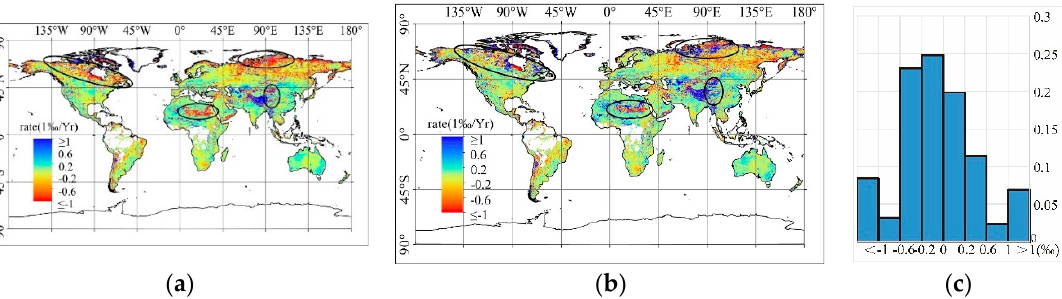
Figure 6. Average rates of change of the annual SM trend before ( a ) and after ( b ) the turning point of the quadratic trends. ( c ) Statistics of global surface SM changing rates. Regions where the rate has changed significantly between the two periods are underlined by black ellipses.